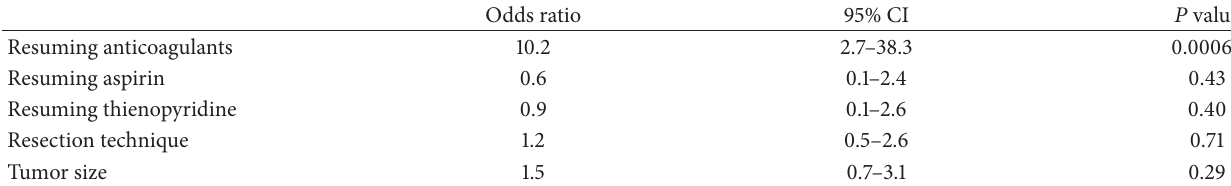
Table 4: Multivariate analysis of risk factors associated with delayed bleeding.